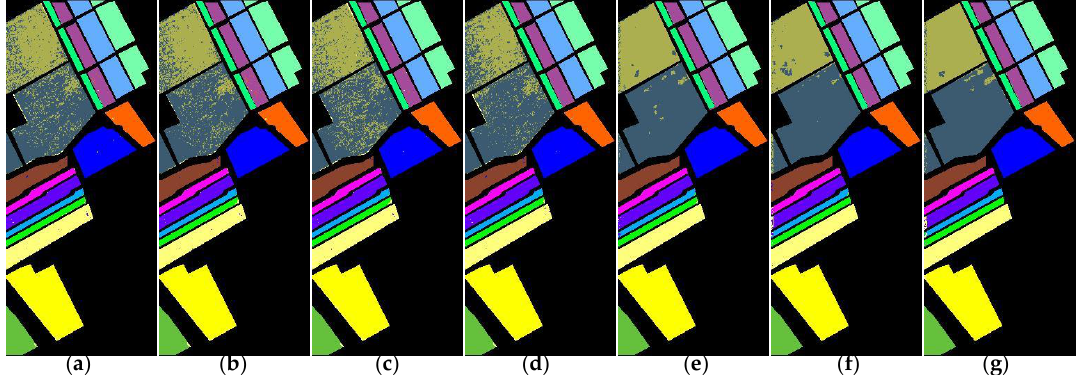
Figure 13. Classification maps for the Salinas dataset obtained by SVM classification after